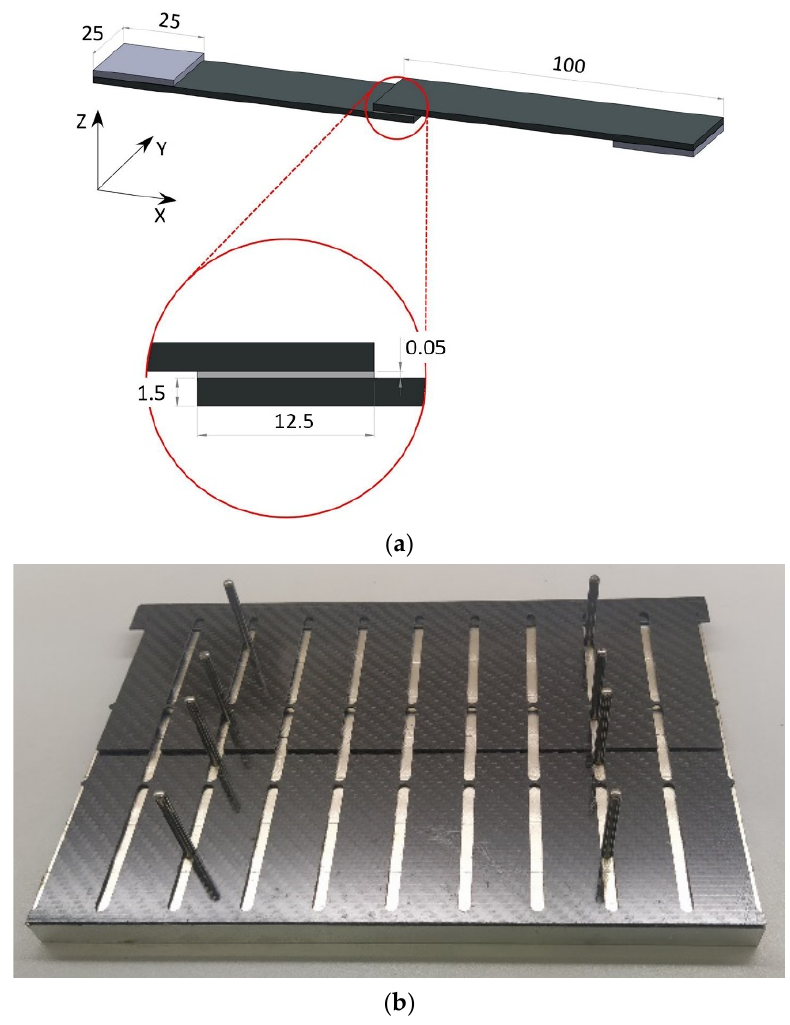
Figure 2. ( a ) Single sample dimensions in mm, and ( b ) bonding jig.